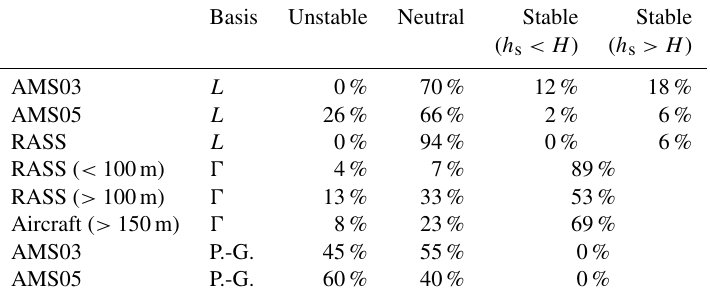
Table 4. Frequency of each stability type during flight times determined by each measurement platform. Stability is either determined by parameterization of Obukhov length ( L ; see Sect. 2.1), by comparison of the temperature profile with the dry adiabatic lapse rate ( (cid:48) ), or using the Pasquill–Gifford stability classification scheme